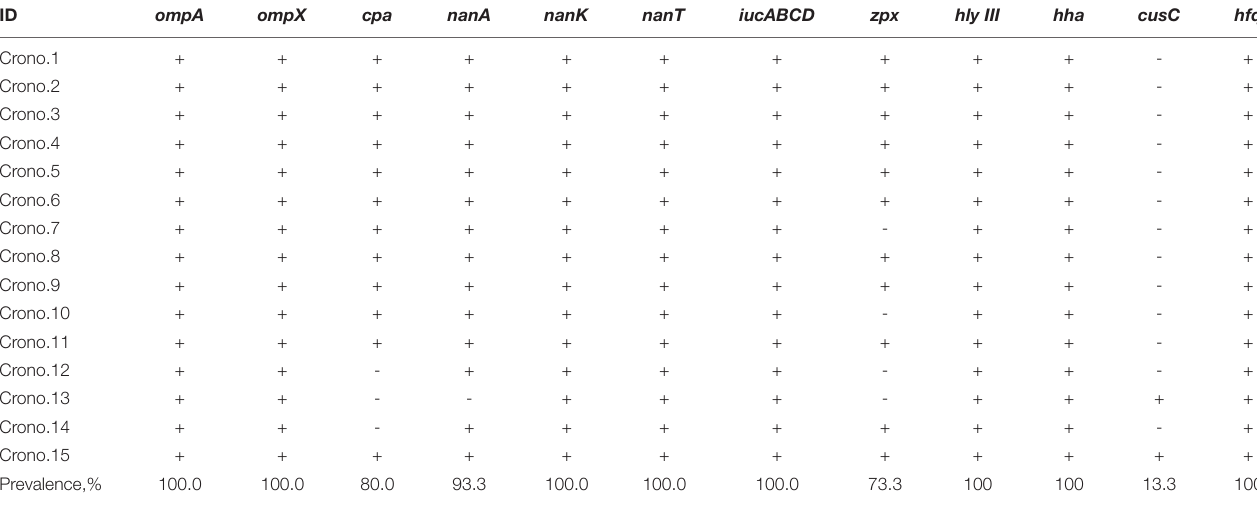
TABLE 2 | Virulence genes harbored by C. sakazakii isolates.